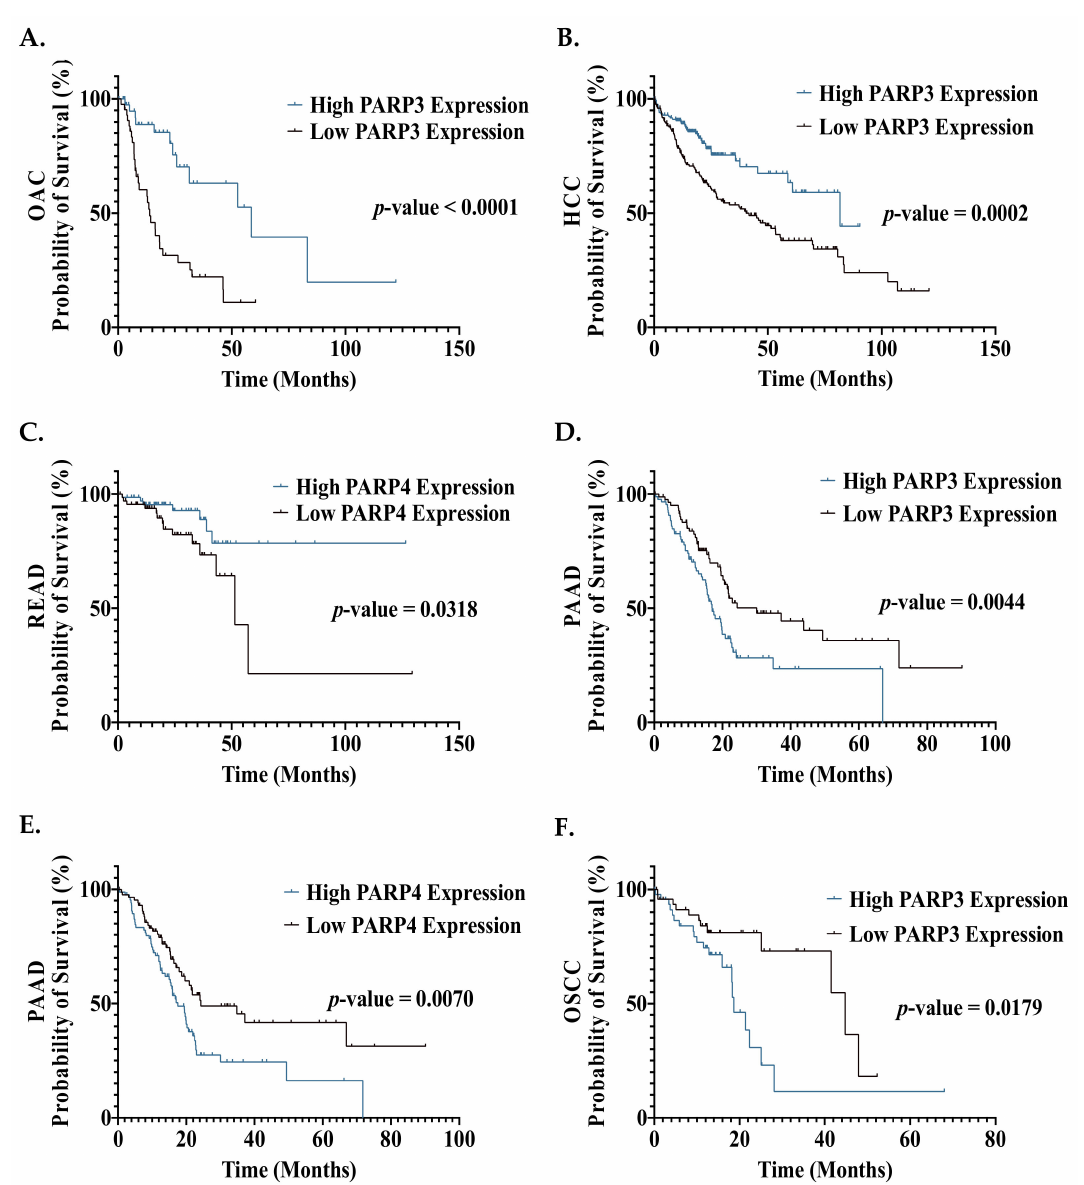
Figure 5. Effect of DDR PARP gene expression on overall survival outcomes of GI cancer patients. ( A ) OAC patients with high PARP3 expression ( n = 43) have significantly improved OS, when compared to OAC patients with low PARP3 expression ( n = 43) (median OS of 58.6 months vs. 13.9 months). ( B ) HCC patients with high PARP3 expression ( n = 181) have significantly improved OS, when compared to HCC patients with low PARP3 expression ( n = 181) (median OS of 81.7 months vs. 40.4 months). ( C ) READ patients with high PARP4 expression ( n = 76) have significantly improved OS, when compared to READ patients with low PARP4 expression ( n = 76) (median OS undefined vs. 51.5 months). ( D ) PAAD patients with high PARP3 expression ( n = 88) have significantly poorer OS, when compared to PAAD patients with low PARP3 expression ( n = 88) (median OS of 17 vs. 30 months). ( E ) PAAD patients with high PARP4 expression ( n = 88) have significantly poorer OS, when compared to PAAD patients with low PARP4 expression ( n = 88) (median OS of 17.5 months versus 24.3 months). ( F ) OSCC patients with high PARP3 expression ( n = 47) have significantly poorer OS, when compared to OSCC patients with low PARP3 expression ( n = 47) (median OS of 18.6 months versus 44.7 months). Statistical analysis was performed using a Kaplan–Meier survival analysis and log-rank (Mantel–Cox)